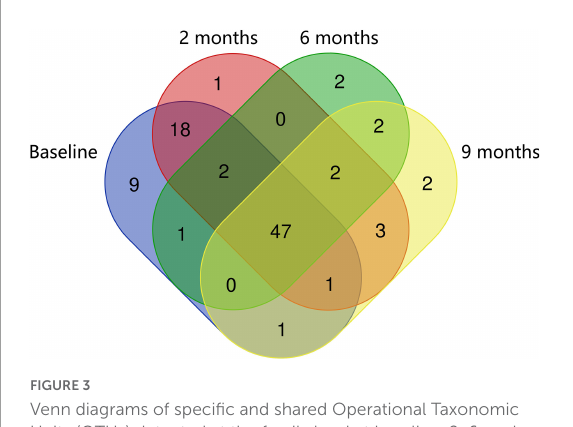
FIGURE3 Venn diagrams of specific and shared Operational Taxonomic Units (OTUs) detected at the family level at baseline, 2, 6, and 9 months of the study.